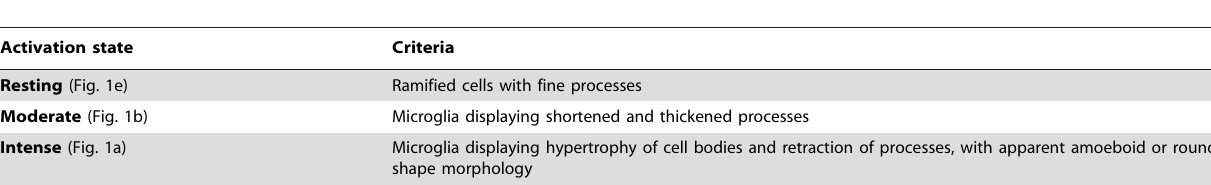
Table 1. Description of the qualitative scoring system for microglia activation state.